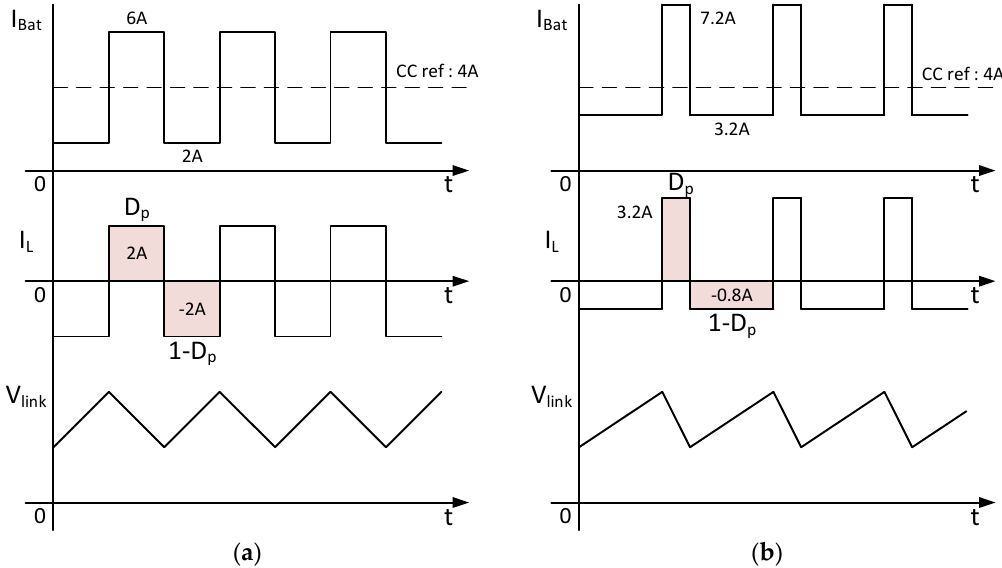
Figure 7. Characteristic waveforms according to the inductor current control: ( a ) D p : 50% and ( b ) D p : 20%.